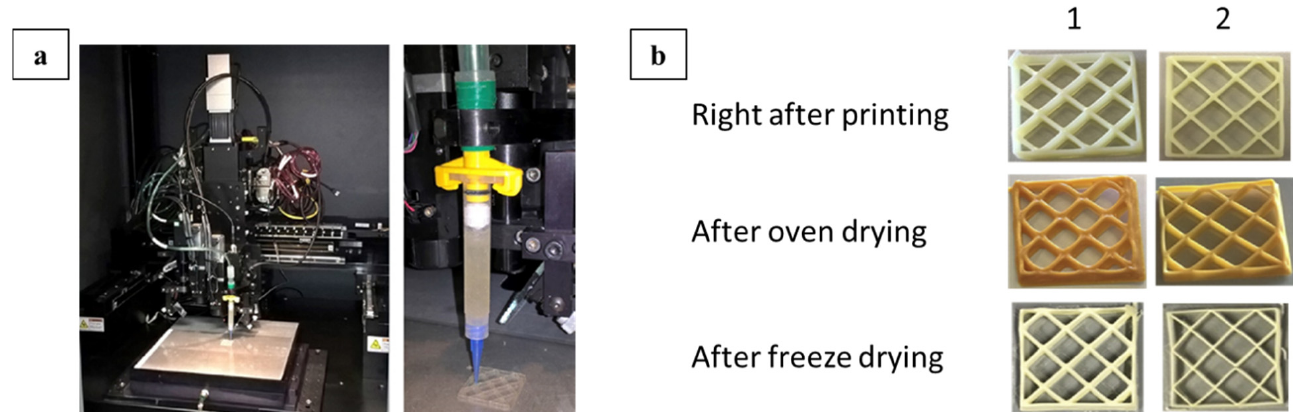
Figure 10. The material extrusion type of device used for 3D printing of food materials ( a ). The effect of the oven freeze- drying on the appearance of 3D-printed samples ( b ): 0.8% CNF + 50% SSMP (1) and 60% SSMP (2), used with permission from ref. [65].